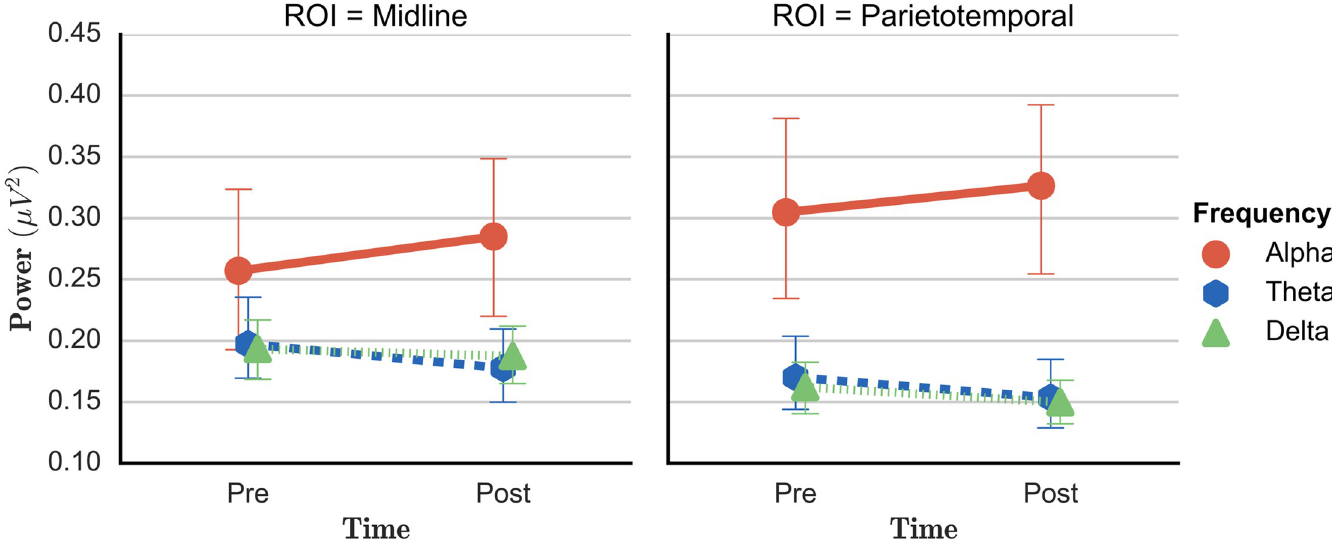
Fig 5. ab. Changes in resting state EEG before and after SCP neurofeedback at midline regions (5a: left) and parietotemporal regions (5b: right) during the eyes-closed condition. The y-axis values are the fraction of the total EEG power. Red line: Increase in alpha frequency band power from before to after SCP neurofeedback training. Decreases from before to after SCP neurofeedback training in delta frequency band (blue line) and theta frequency band power (green line). Vertical lines represent the standard error.